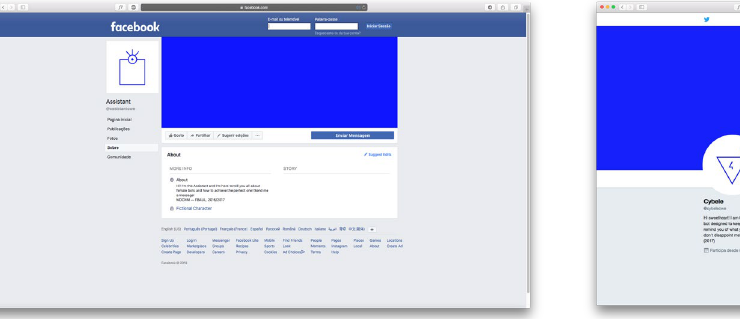
Figure 6 | Cybele’s twitter